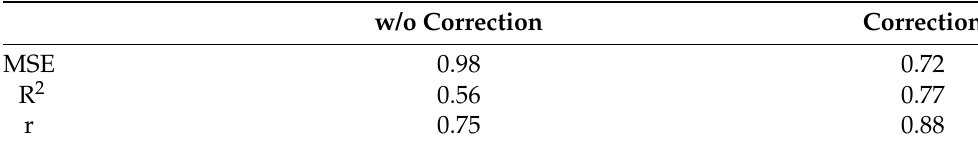
Table 6. Regression results without